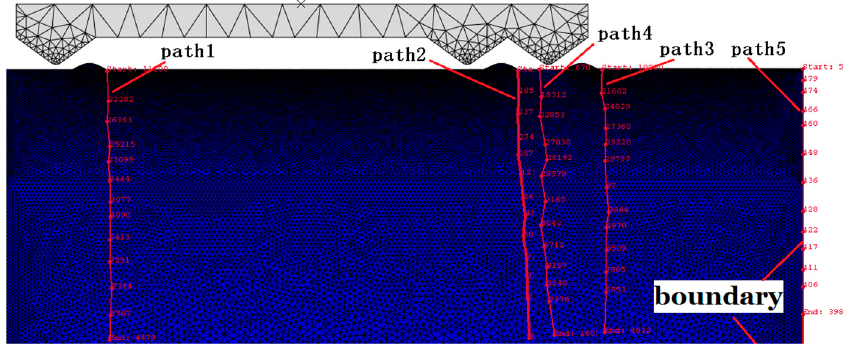
Figure 4. Paths distribution of subsurface damage.